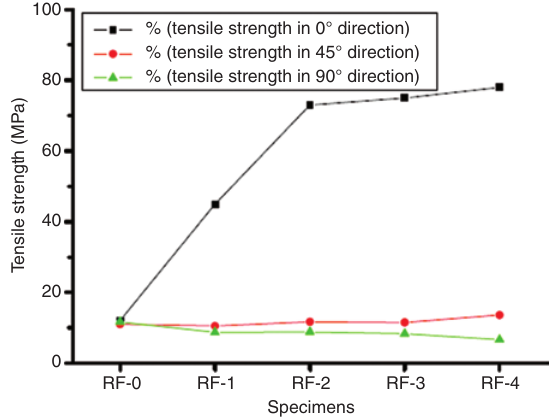
Figure 5: Tensile strength of CR reinforced with different numbers of polyester tire cord layers at the 0 ° , 45 ° , and 90 ° directions.